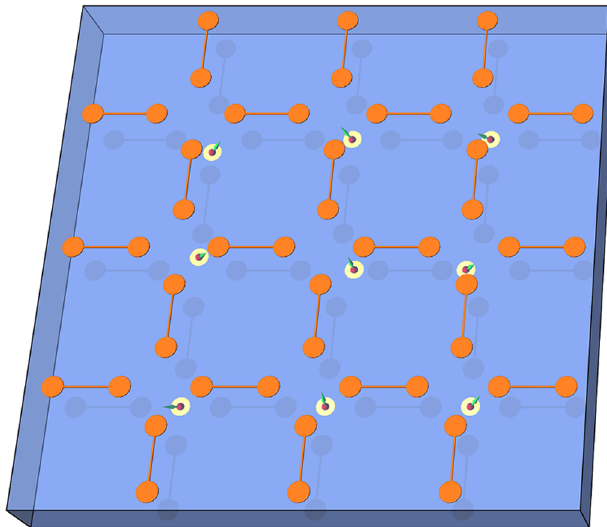
FIG. 3. Quantum-computer architecture using metallic floating gates on top of a 2DEG. The electrostatic long-range coupling is confined to adjacent qubits. Turning on (off) the qubit-qubit interaction is achieved by moving a qubit close to (away from) the corresponding metal disc. This architecture allows for par- allel switching.